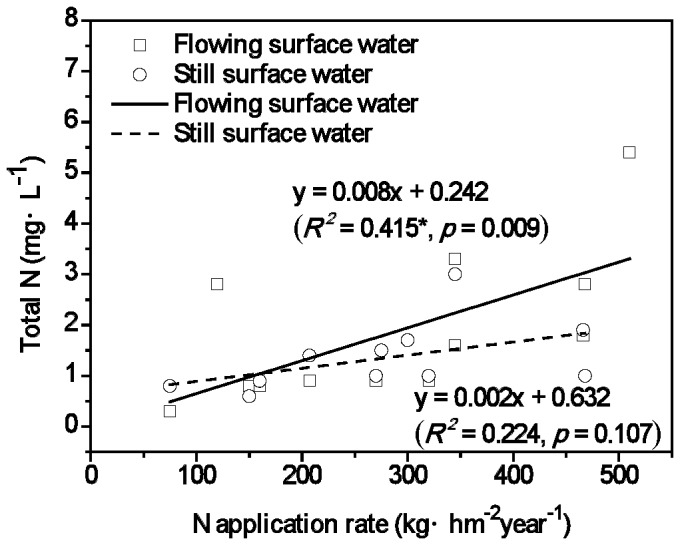
Correlations of total nitrogen concentrations and soil N fertilizer application rates in agro- and oasis agro- ecosystems (p < 0.05, n = 15).The total nitrogen concentrations in this figure were the median values of agro- and oasis agro- ecosystems.